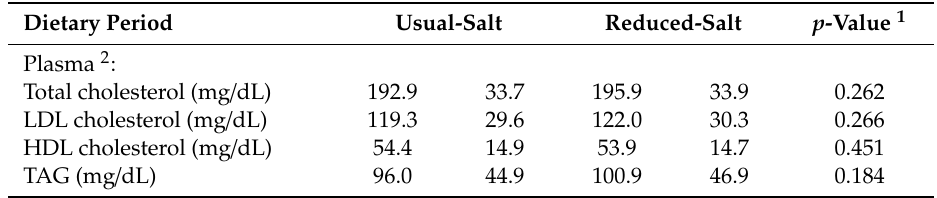
Table3. Bloodlipidsinadultswithmildlytomoderatelyelevatedbloodpressureduringthereduced-salt and usual-salt dietary periods. Dietary Period Usual-Salt Reduced-Salt p -Value 1 Plasma 2